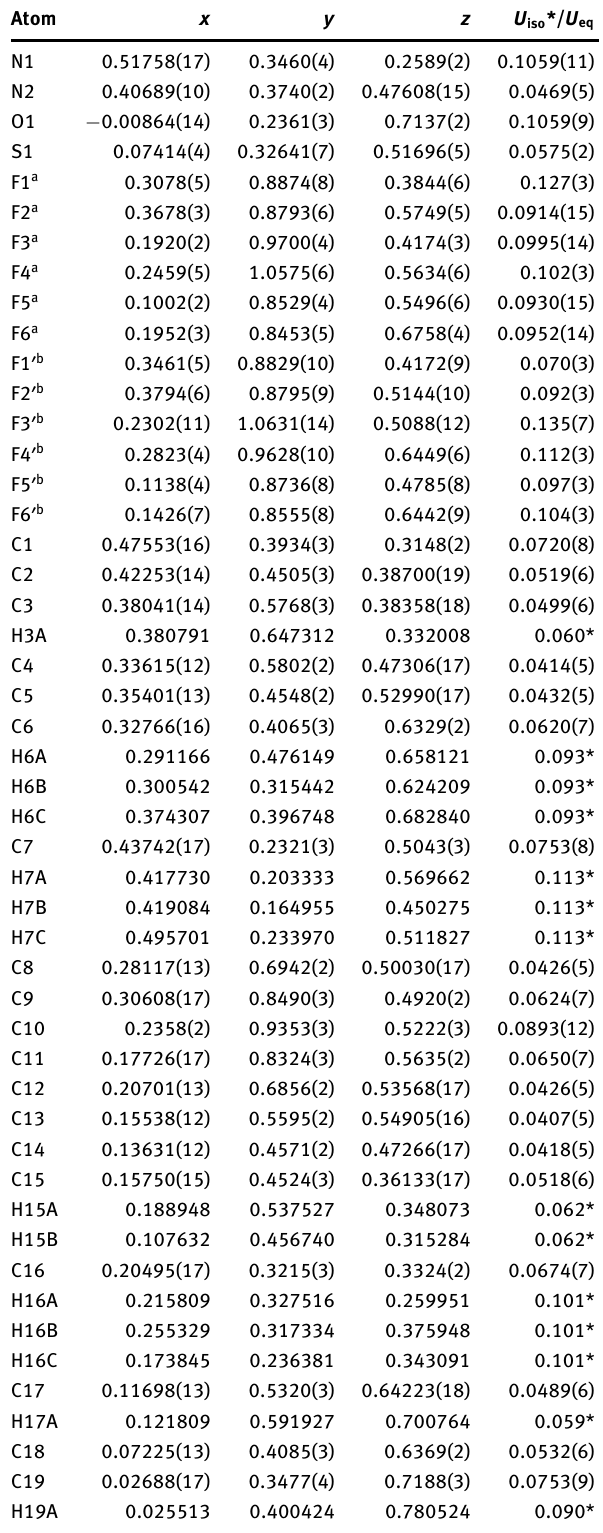
Table 2: Fractional atomic coordinates and isotropic or equivalent isotropic displacement parameters (Å 2